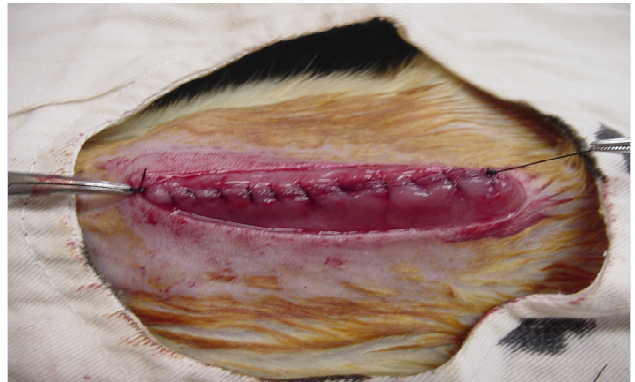
FIGURE 1 – Closure of the aponeurosis using the nylon suture